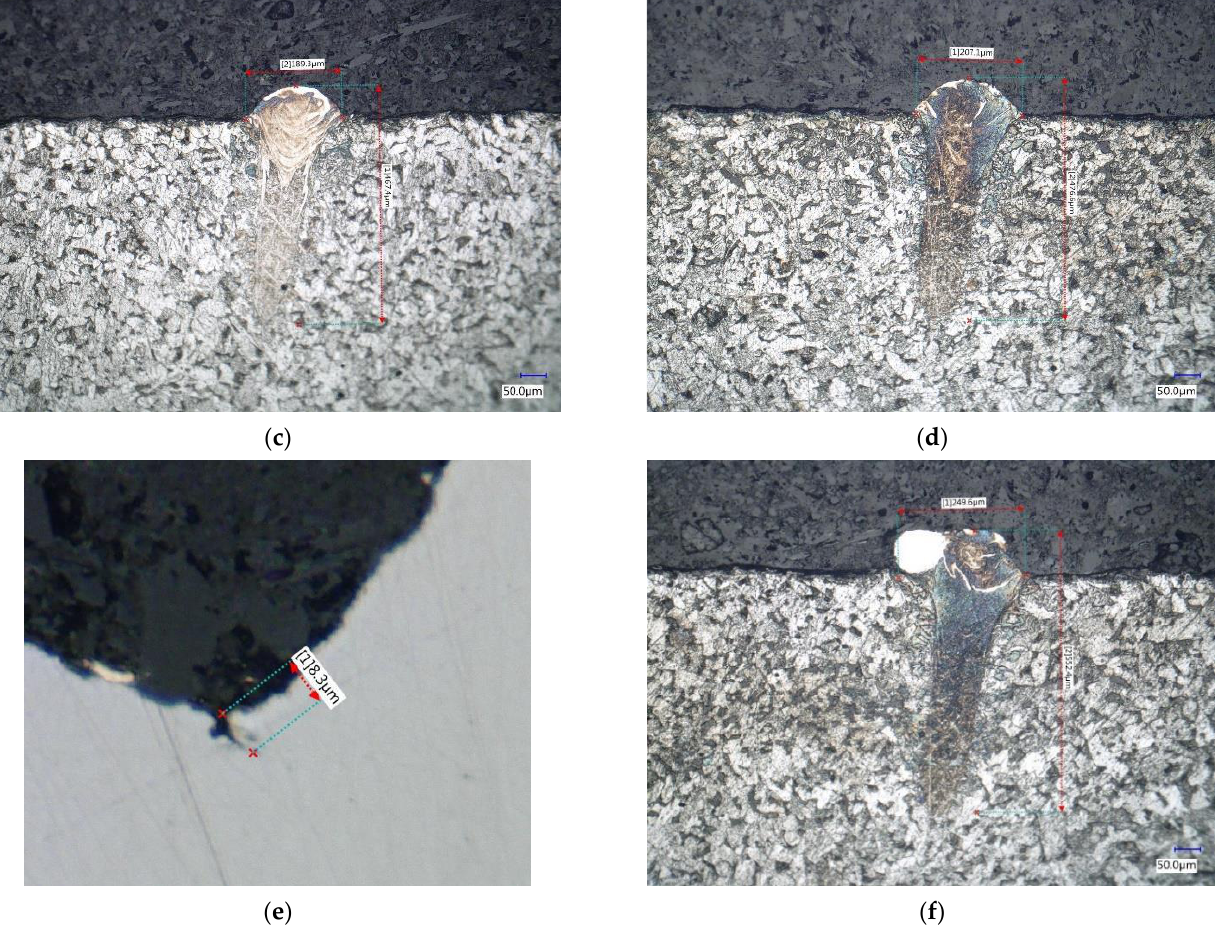
Figure 10. Metallographic images of selected welds ( a ) weld No. 3; ( b ) weld No. 6; ( c ) weld No. 10; ( d ) weld No. 12; ( e ) crack on weld No. 7; ( f ) defect on weld No. 11. Table 10. The best-evaluated